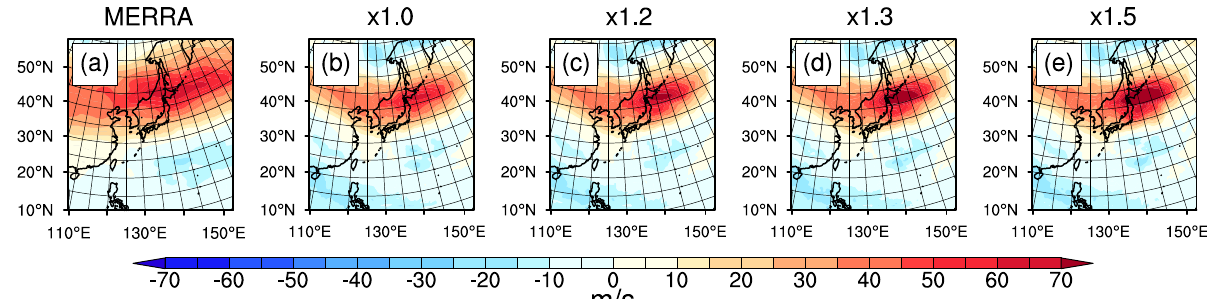
Figure 7. The average 250-hPa zonal winds during simulation time (1–5 October 2016) for observation ( a ) and each simulation ( b – e ).